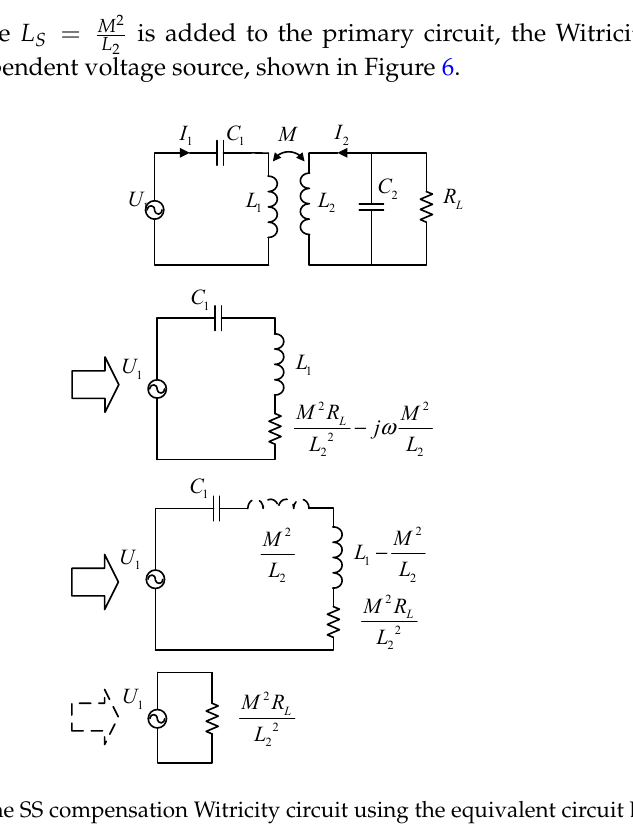
Figure 6. The SS compensation Witricity circuit using the equivalent circuit B.